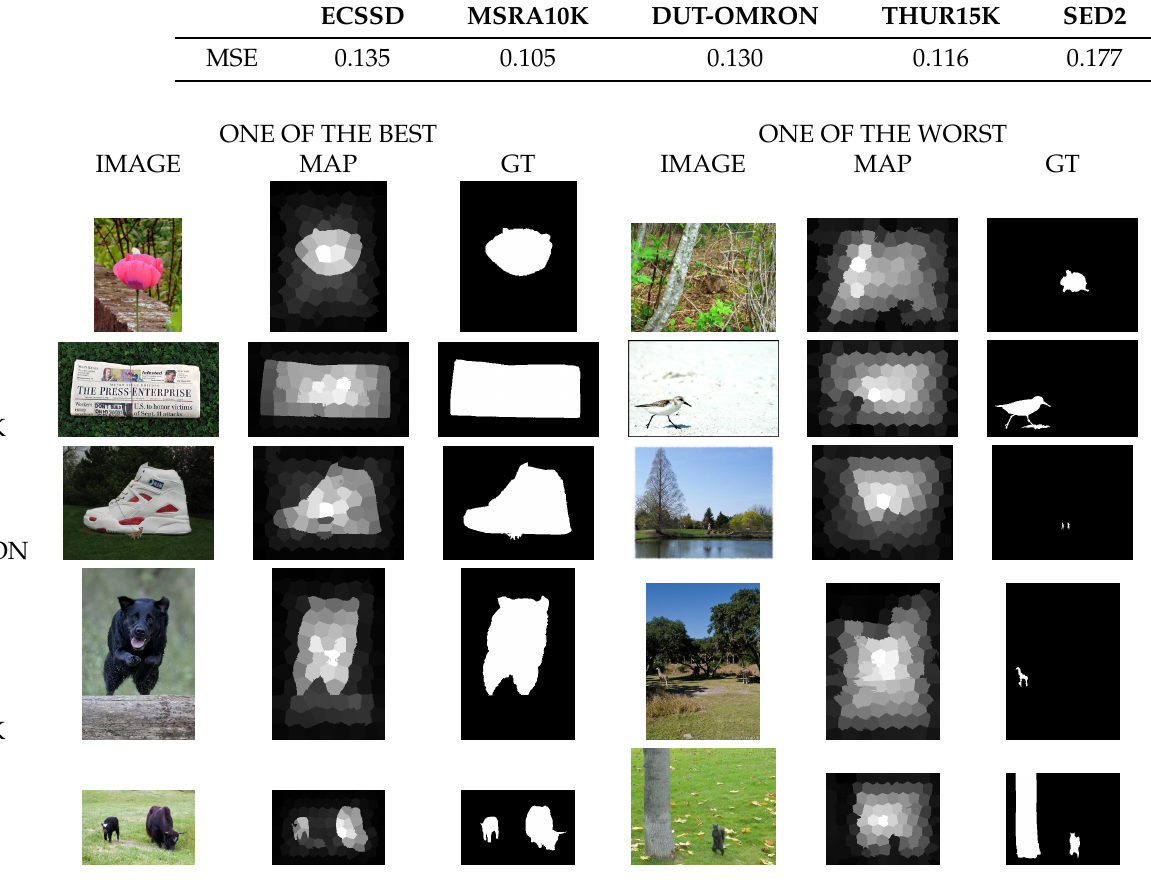
Figure 9. One of the best and one of the worst saliency maps for each dataset used in this work.